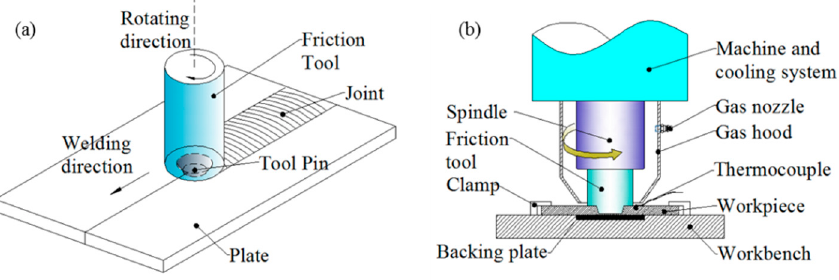
Figure 1. ( a ) Schematic illustration of friction stir welding (FSW), ( b ) schematic diagram of FSW equipment of Ti alloys.